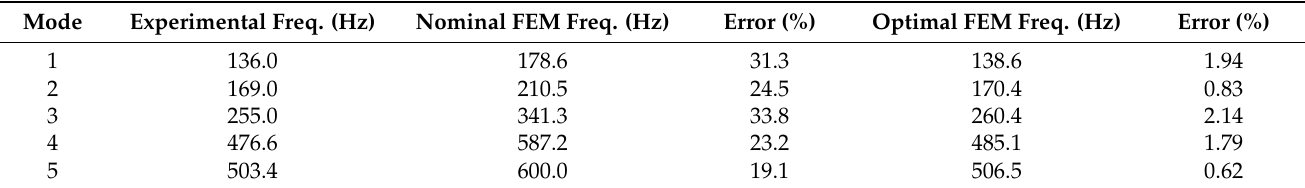
Table 5. Comparison of the Experimental natural frequencies with the Nominal (before the model update procedure) and Optimal Finite Element Model (after the model update procedure).